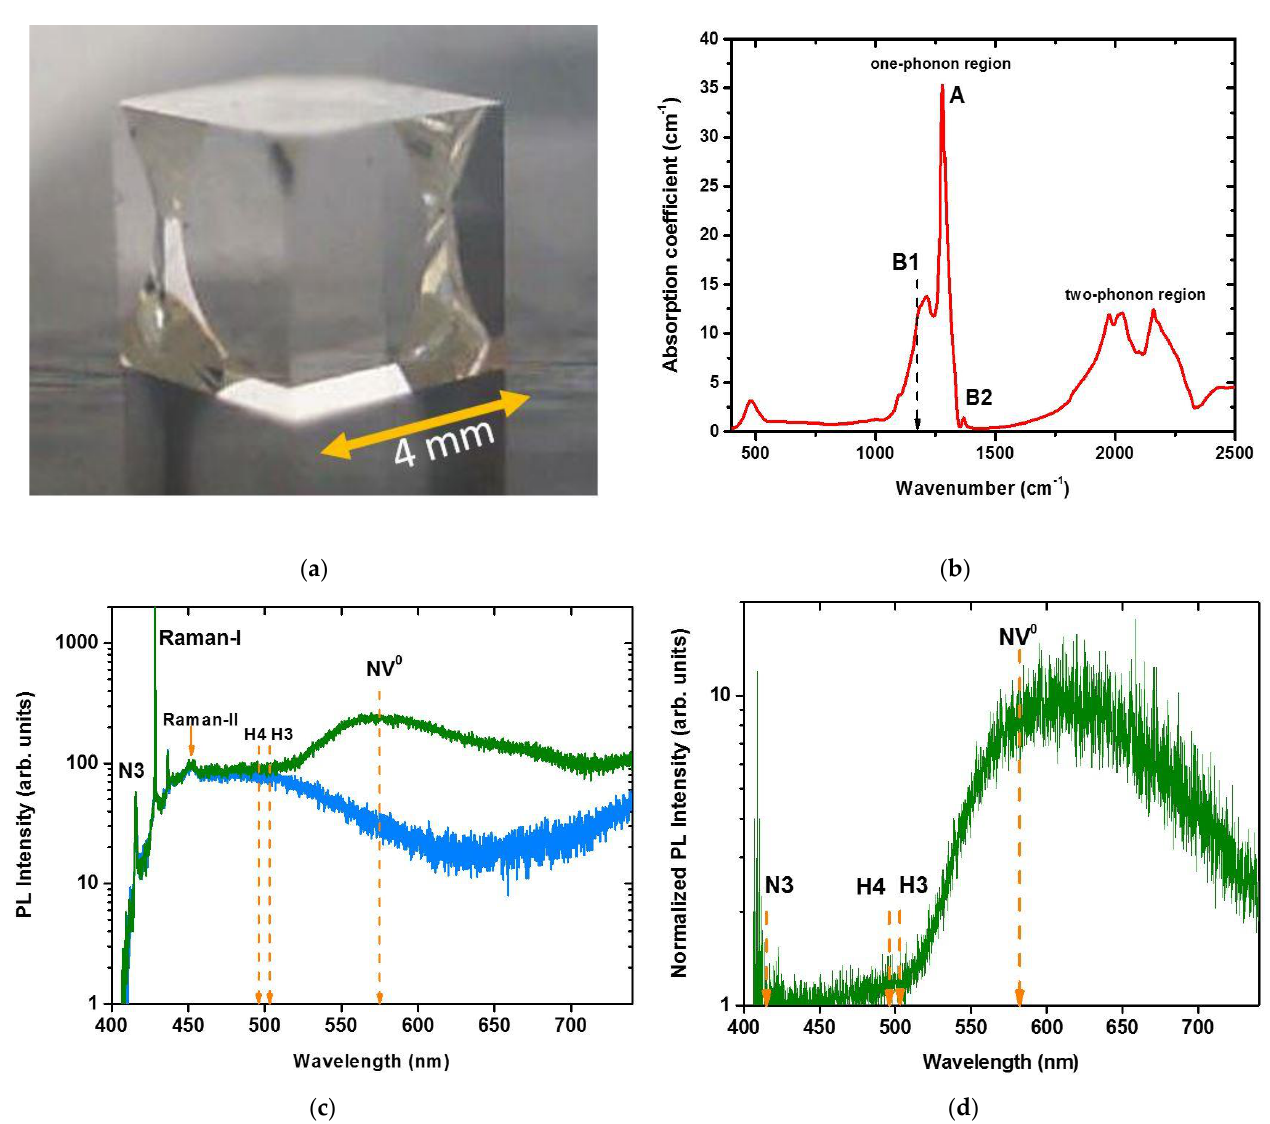
Figure 2. ( a ) Image of the natural IaAB-type diamond cubic sample. ( b ) FT-IR spectrum of the initial diamond with its spectral assignment after [10]. ( c ) PL spectra of the reference diamond region (blue curve, bottom one) and its micromark (green curve, top one) inscribed at 2.1 MW (fluence — 5.5 J/cm 2 , intensity — 18 TW/cm 2 ) and 240 s (24 × 10 6 pulses) at the 280 μ m depth. Spectral assignment after [10]. ( d ) Spectrum of normalized PL intensity, obtained by dividing the second spectrum in ( c ) by the first one (micromark/reference). Spectral assignment after [10].